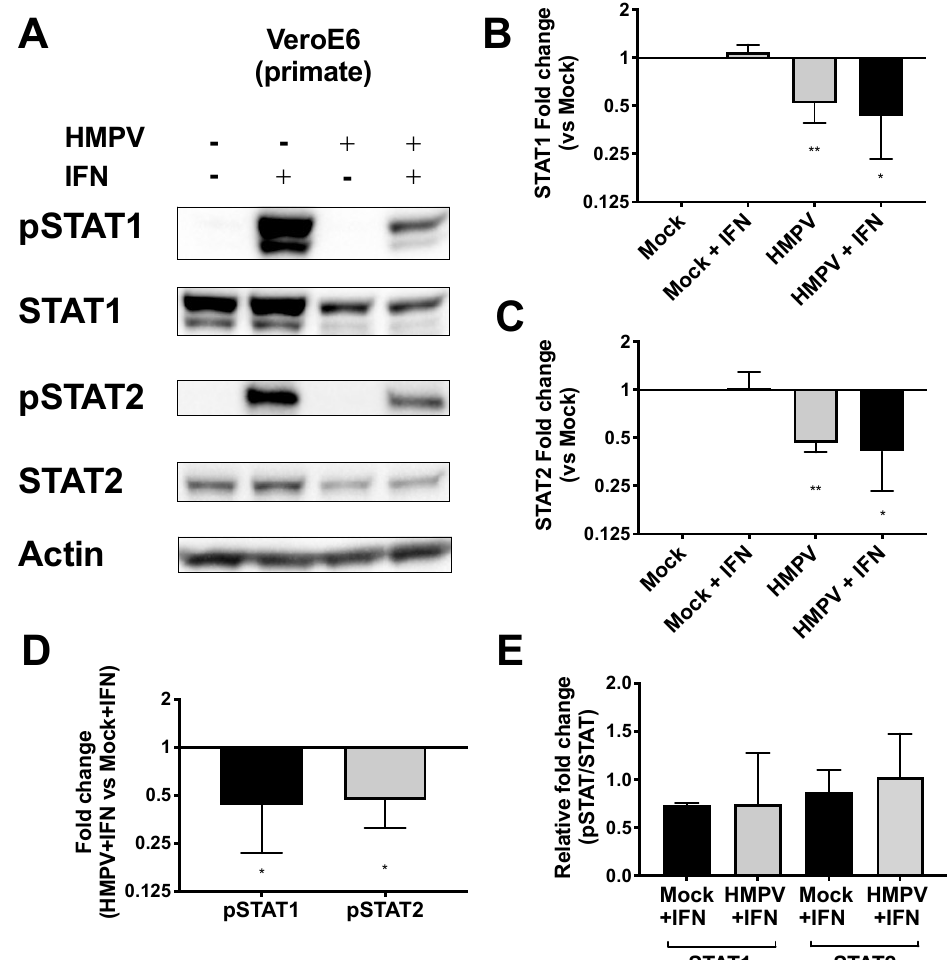
Figure 3. HMPV reduces STAT1 and STAT2 activation in primate cells. ( A ) VeroE6 (primate) cells were infected with HMPV for 24 h, then treated with IFN for 30 min before cells were lysed for Western blotting against total and phosphorylated STAT1 and STAT2. ( B , C ) Fold change of total STAT1 ( B ) and STAT2 ( C ) expression normalized to value of mock-infected cells. ( D ) Fold change of pSTAT1 and pSTAT2 compared to mock-infected cells. ( E ) Relative fold change of pSTAT1 and pSTAT2 (fold change of pSTAT1 / 2 divided by fold change of STAT1 / 2). * p < 0.05, ** p < 0.01, one sample t test comparison to normalized mock value of 1. Data are representative of ( A ) or combined from ( B – E ) four independent experiments.